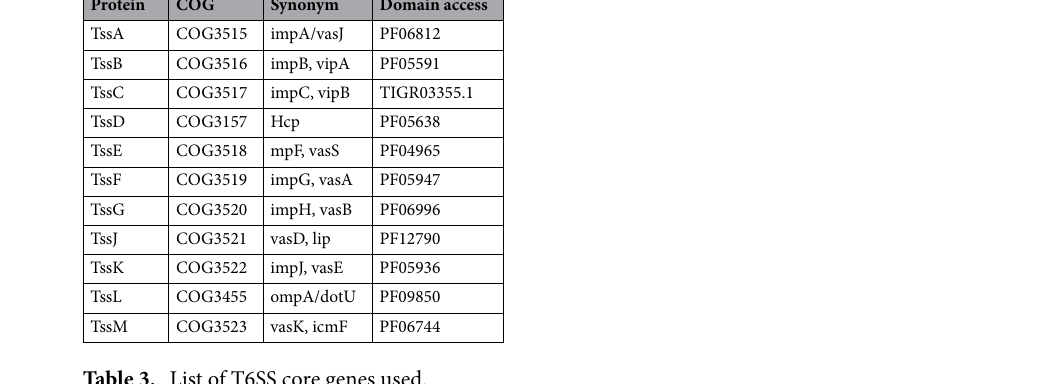
Table 3. List of T6SS core genes